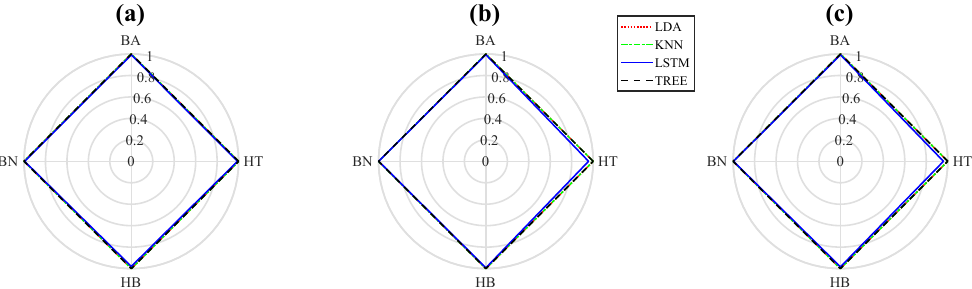
Figure 5. The resulting graphs of four single classes: ( a ) precision, ( b ) recall, and ( c ) F1.